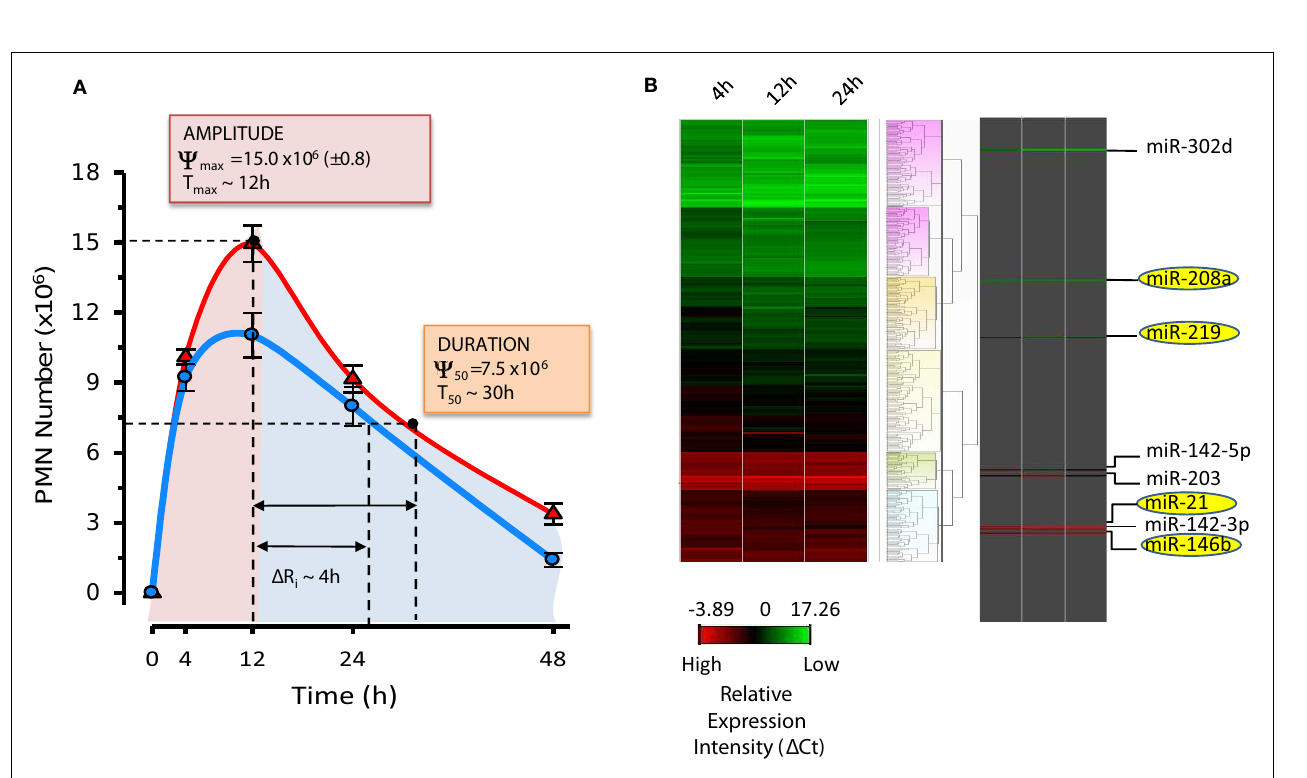
FIGURE 7 | Resolution indices and miRNA signature of resolution. (A) Resolution indices were calculated as in (Bannenberg et al., 2005) using PMN numbers in peritoneal exudates from mice treated with zymosan alone (red line) and zymosan plus RvD1 (blue line) at indicated time intervals: T max , time of maximum PMN infiltration ( Ψ max ); T 50 , time to achieve 50% reduction in PMN number ( Ψ 50 ) from Ψ max ; R i , resolution interval ( T 50 − T max ; time interval between T max and T 50 ). RvD1, administered at the beginning of peritonitis,